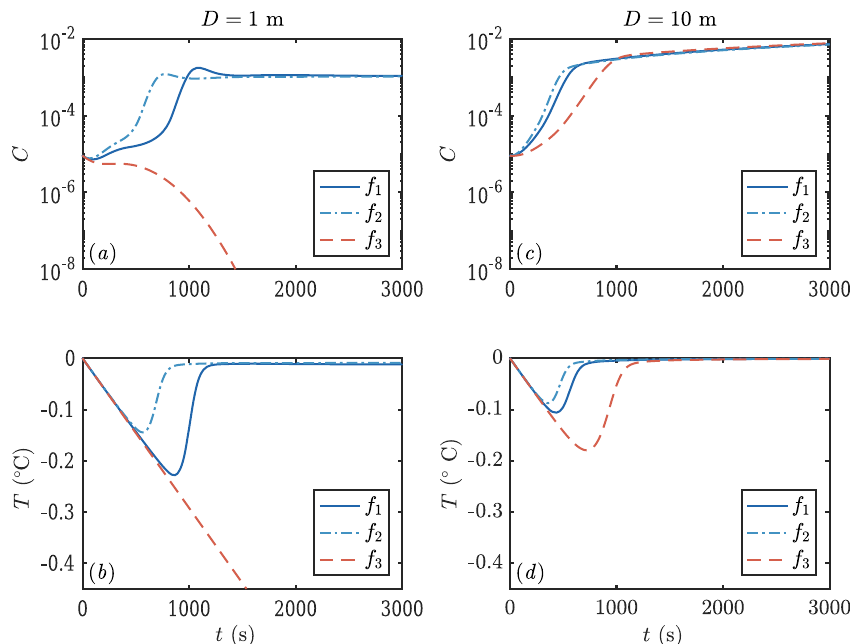
Figure 6. Evolution of crystal concentration (a, c) and mixed-layer temperature (b, d) using the three growth rate formulae discussed in Sect. 1.2. Using D = 1m leads to frazil explosions for growth laws 1 and 2, but the population collapses for growth law 3. For a deeper mixed layer D = 10m, all the growth laws result in a frazil explosion. Other parameters are as in Fig. 3.